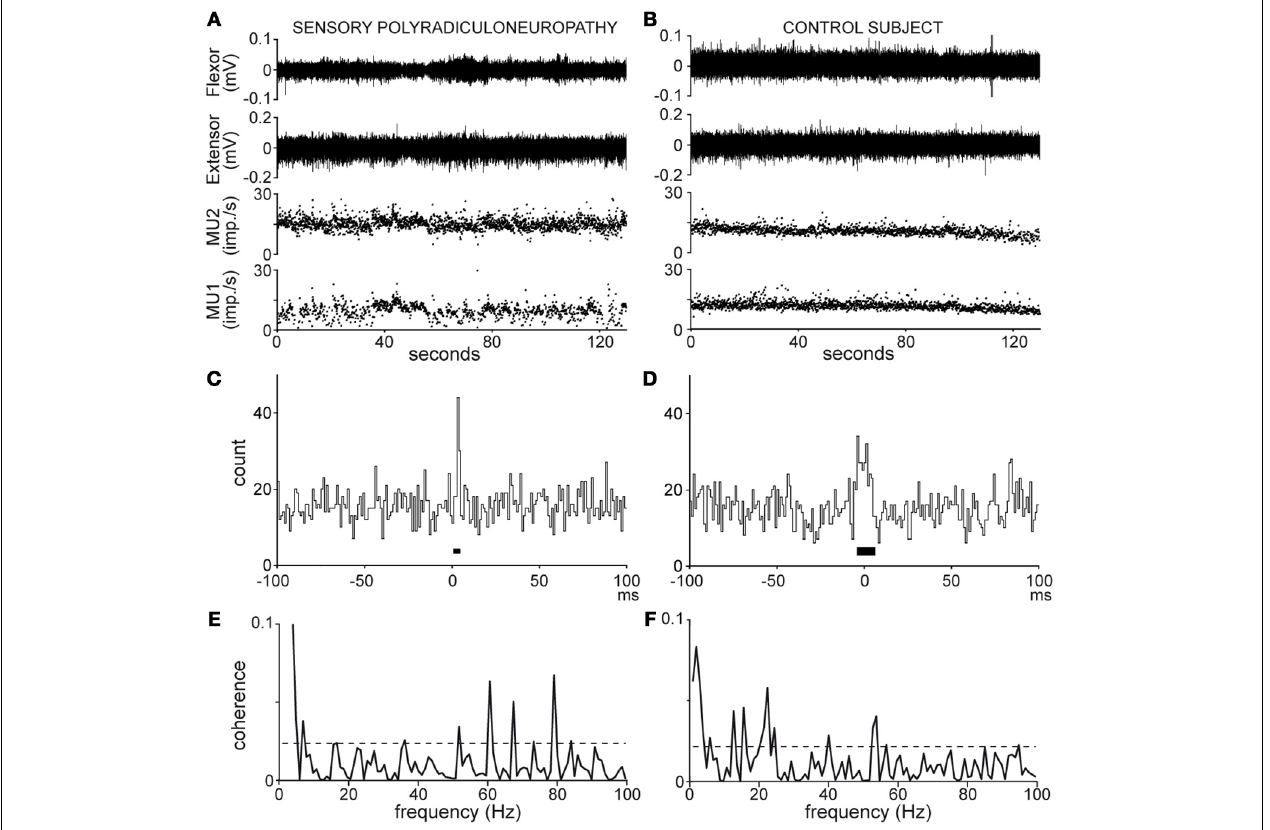
frequency (bottom traces); (C,D), cross-correlograms [synchronization peak width (black bar) 4 and 12ms, synchronous impulse probability 0.04 and 0.08]; (E,F), coherence spectra (dotted line, significance